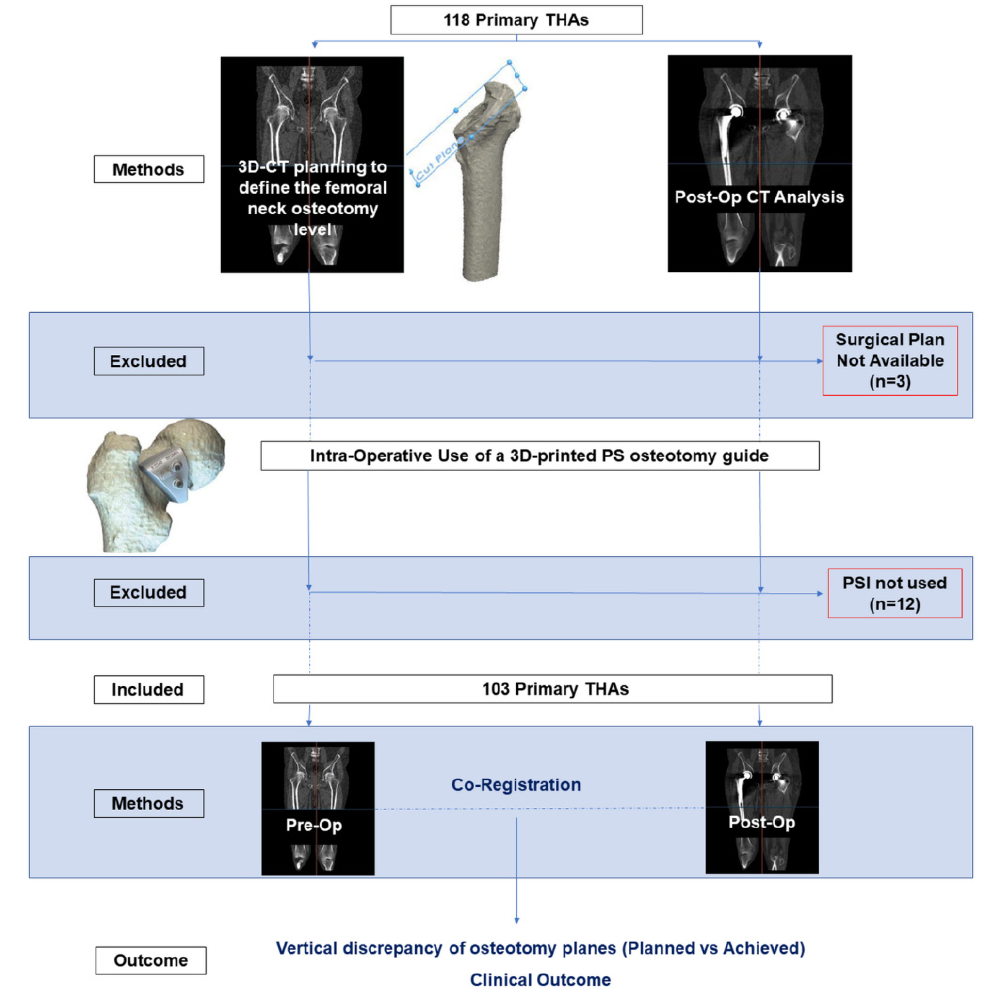
Figure 1. Study Figure 1. Study design.